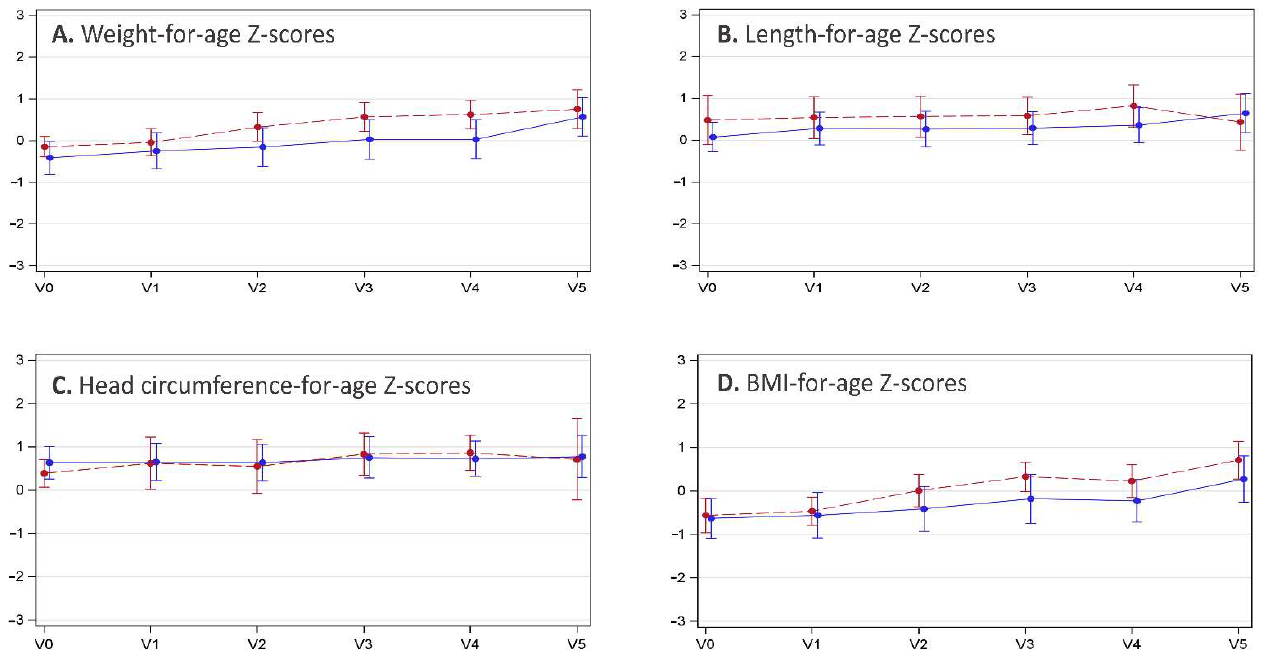
Figure 2. Anthropometric measurements are presented as mean Z-scores (WHO child growth standard) at enrollment (Visit 0, V0), the 1-month (V1), 2-month (V2), 3-month (V3), and 4-month follow-up visits, as well as the end-of-study visit at 12 months of age (V5). Error bars indicate the standard deviations. The blue dots/solid lines summarize the growth data for male infants, and red dots/broken lines summarize that for female infants. The four panels depict ( A ) weight-for-age, ( B ) length-for-age, ( C ) head circumference-for-age, and ( D ) body mass index (BMI)-for-age Z-scores.